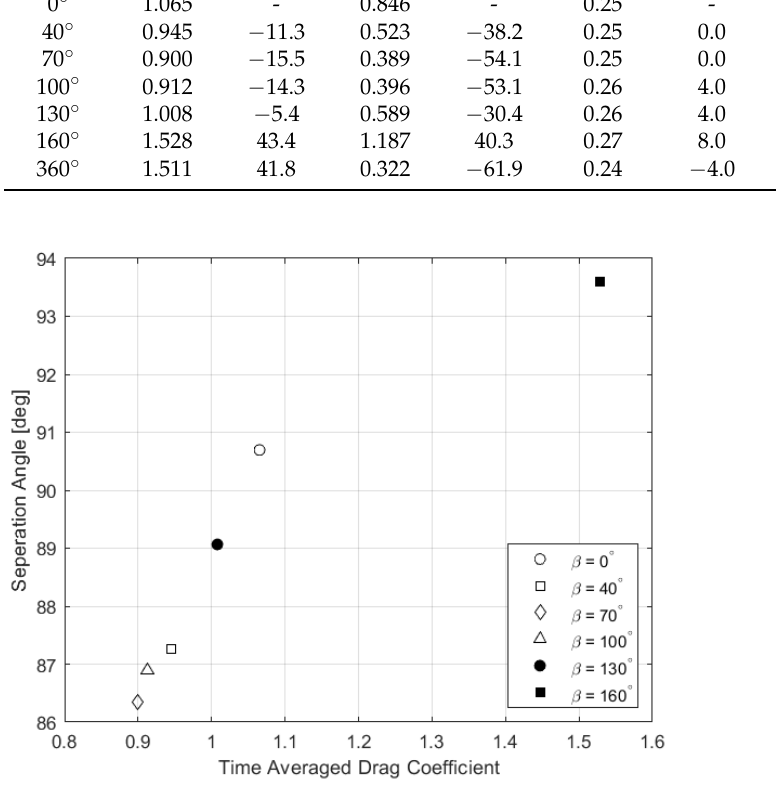
Figure 7. Variation in the separation angle with the time-averaged drag coefficient at Re = 4.2 × 10 4 , constant thickness t / D = 14.3% and a porosity of 20